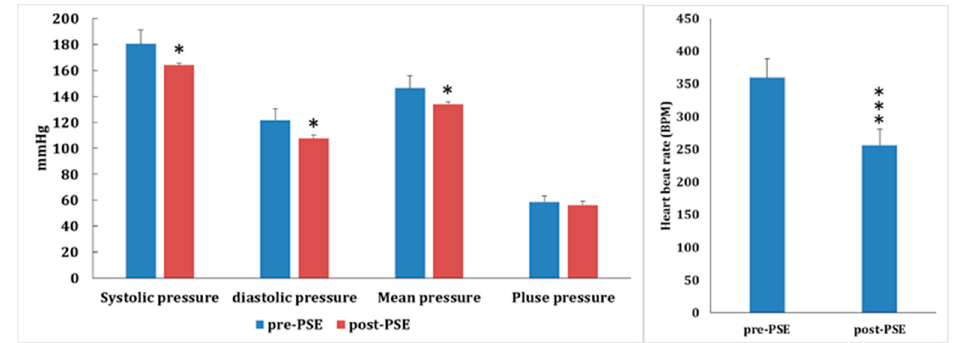
Figure 2. The acute antihypertensive effects of Plantago asiatica seed extracts (PSEs, 360 mg/kg, p.o., 1 h) on SHR rats ( n = 5). Systolic pressure decreased about 16.5 mmHg, diastolic pressure decreased about 14.3 mmHg, the mean arterial pressure decreased about 12.1 mmHg, and heart beat rate was reduced about 100 BPM, but there was no significant effect on pulse pressure (* p < 0.05, *** p < 0.001). Figure 3. The acute antihypertensive effects of Plantago asiatica seed extracts (PSEs, 360 mg/kg, p.o,, 1 h) on P1-HT rats ( n = 15). Systolic pressure decreased about 31.5 mmHg, diastolic pressure decreased about 18.5 mmHg, the mean arterial pressure decreased about 22.3 mmHg, pulse pressure decreased about 12.9 mmHg, and heart beat rate decreased about 100 BPM (*** p < 0.001).